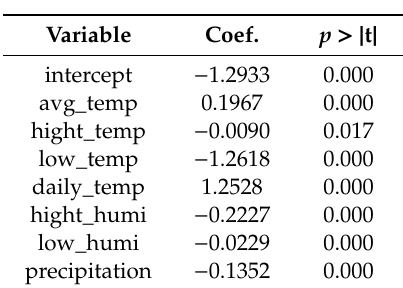
Table 3. Result of OLS.